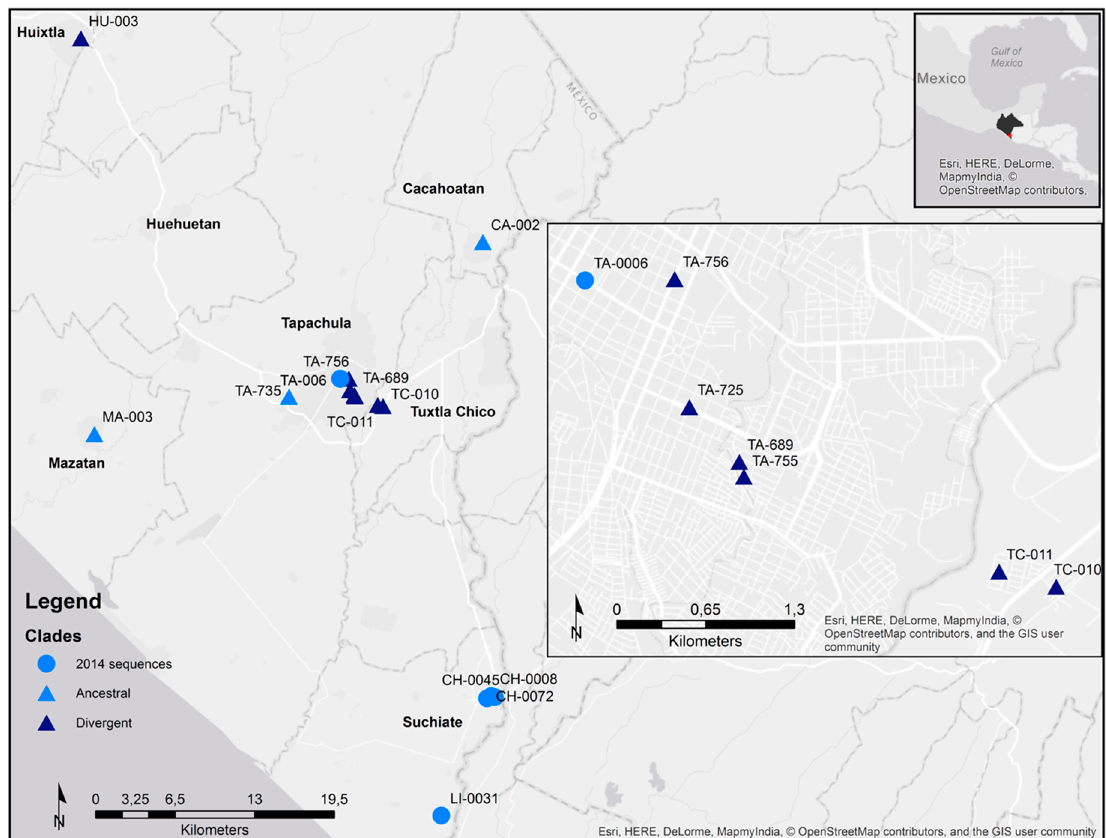
Figure 4. Chikungunya virus strains distribution across Chiapas, Mexico, 2014–2015. The different municipalities were CHIKV was isolated and sequenced are labeled. The upper right square indicates the location of Tapachula municipality and Chiapas state. The middle right square is a magnification of the sequences from Tapachula and Tuxtla Chico. The previously sequenced strains [42] are indicated with a circle. The newly sequenced strains are indicated with a triangle. The triangles of the divergent sequences are darker. We used the World Light Gray base by Esri (Esri Inc.) [41].